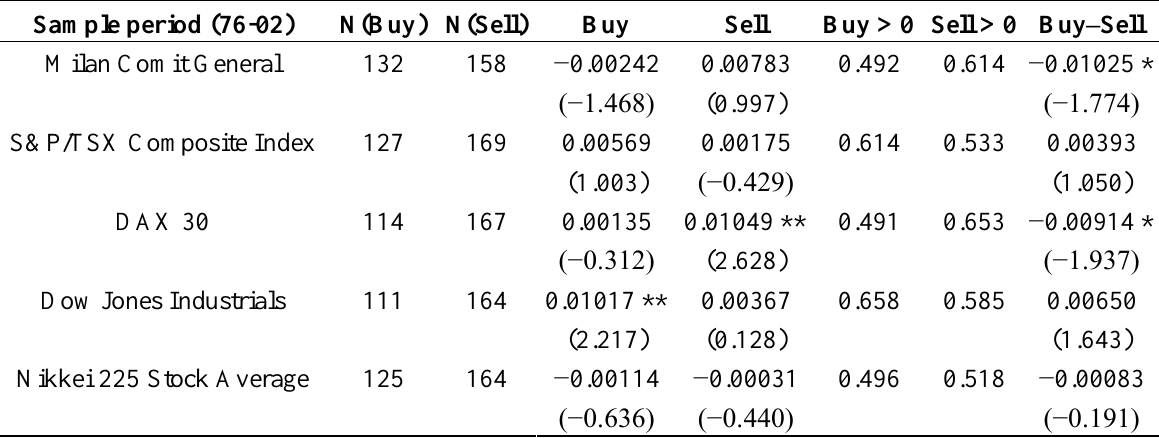
Table 3E. Average ten-day returns from RSI (14, 30/70).